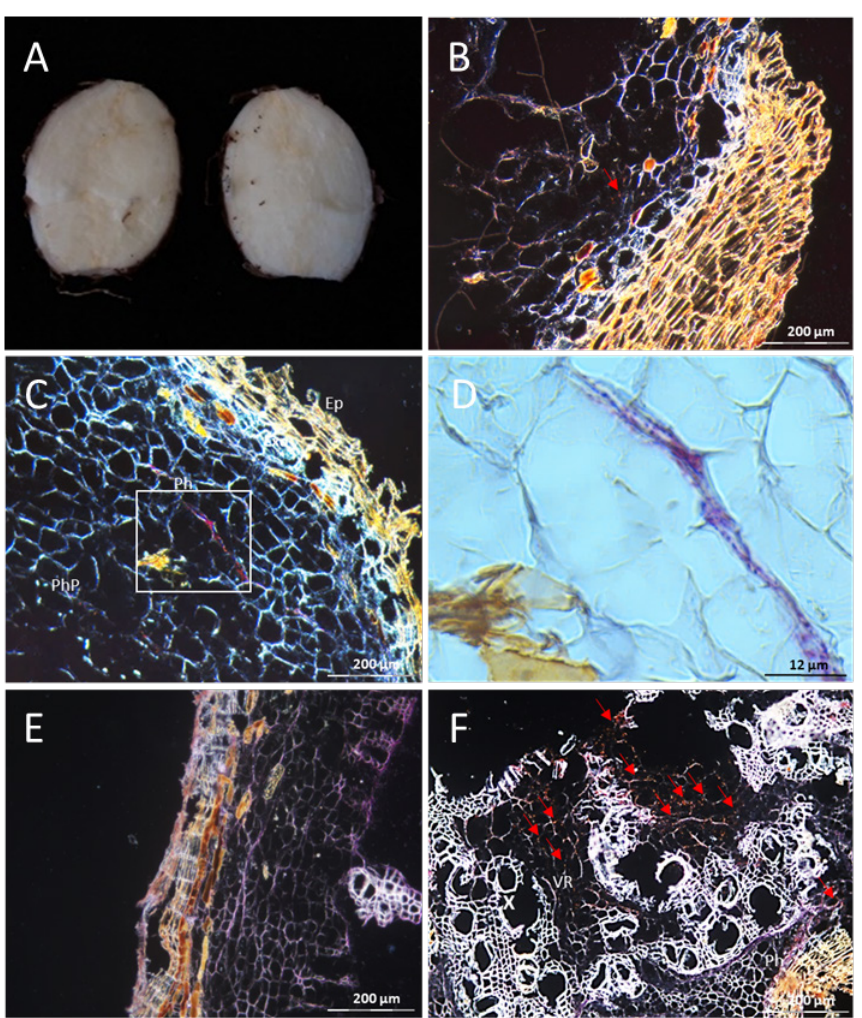
Figure 7. Distribution of CBSV-Mo83 RNA in cross sections of DSC 167 and TMS 96/0304 tuberous roots. ( A ) Longitudinal cutting in DSC 167 cassava tuberous roots. ( B , C ) Cross sections of cassava DSC 167 root tuber subjected to RNAscope ® ISH using a CBSV-Mo83 probe showing few red dots in phloem cells (arrow). ( D ) Close–up images of ( C ). ( E ) Section of an uninfected tuberous root subjected to RNAscope ® ISH. ( F ) Virus presence in phloem and non-phloem cells (arrows) of TMS 96/0304. X, xylem; VR, vascular ray parenchyma cells; Ph, phloem; Ep, epidermis; Exo, exodermis; PhP, phloem parenchyma.